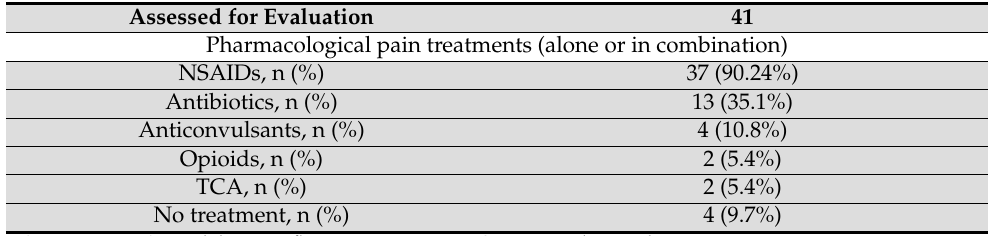
Table 4. Pharmacological treatments in the PIFP population (41 patients).